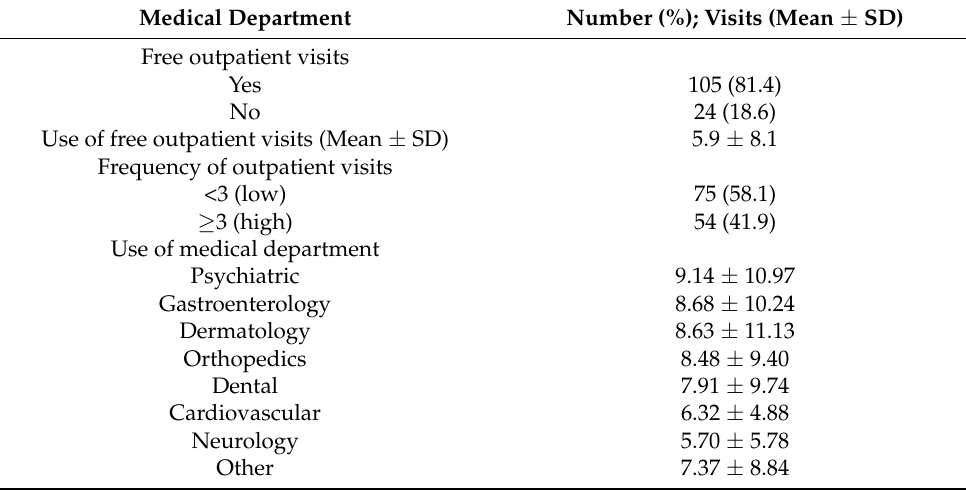
Table 2. Free hospital outpatient visits in the prior three months ( n =